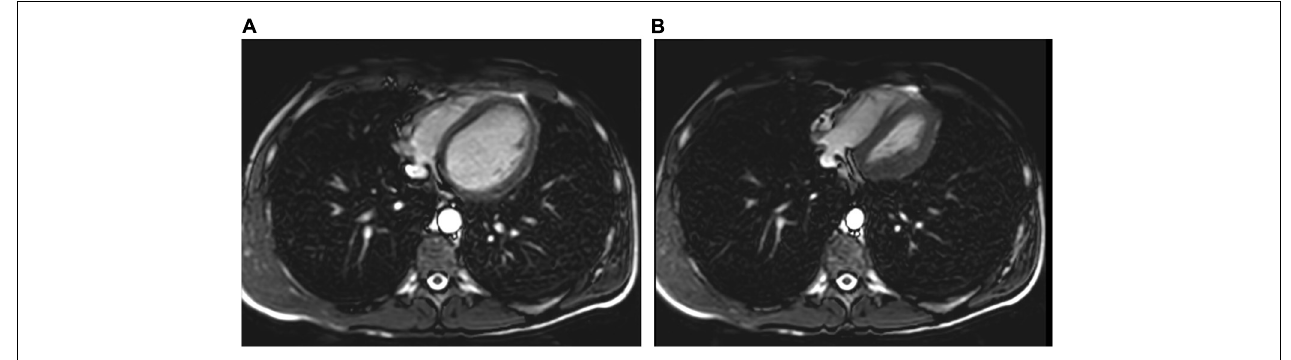
FIGURE 2 | Pulmonary hyperinflation disrupts cardiac filling and leads to cardiac dysfunction. Panel (A) axial slice shows normal filling whereas Panel (B) demonstrates cardiac dysfunction with impaired left ventricular filling and right ventricular overload (D-shaped configuration) and reduced aortic